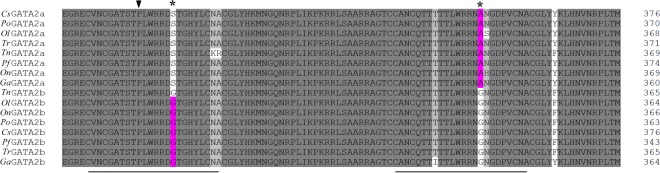
Partial multiple sequence alignment of the deduced GATA2a and GATA2b protein sequences.In teleosts, two conserved zinc finger motifs were found in GATA2a and GATA2b (underlined sequences). Two GATA2b-specific mutations were identified in zinc finger motifs (star-shaped site). The proline site (arrowhead) in the N-terminal zinc finger motif had undergone positive selection.